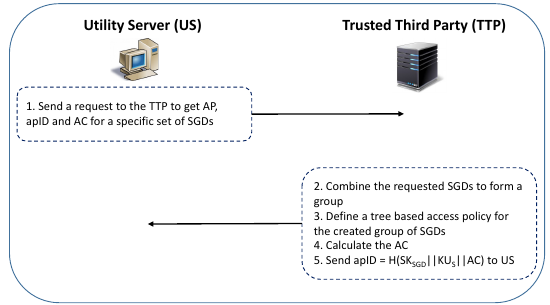
Figure 2. A utility server request to the trusted third party to get access policy, its ID, and authentication